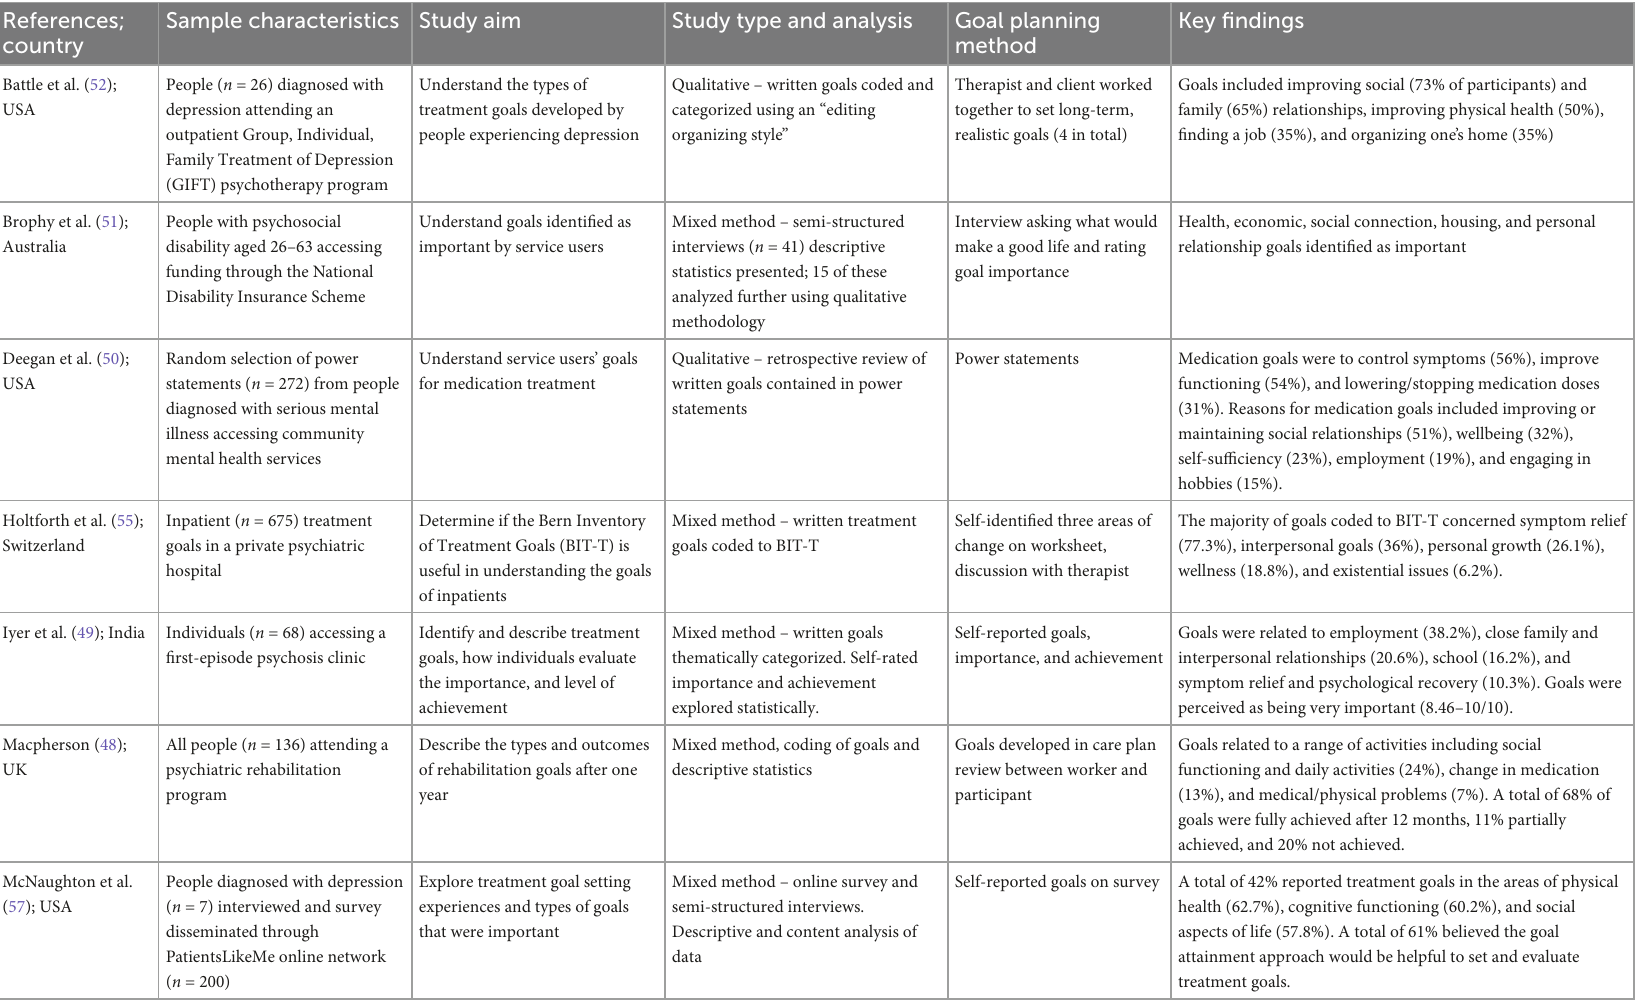
TABLE 2 Types of goals